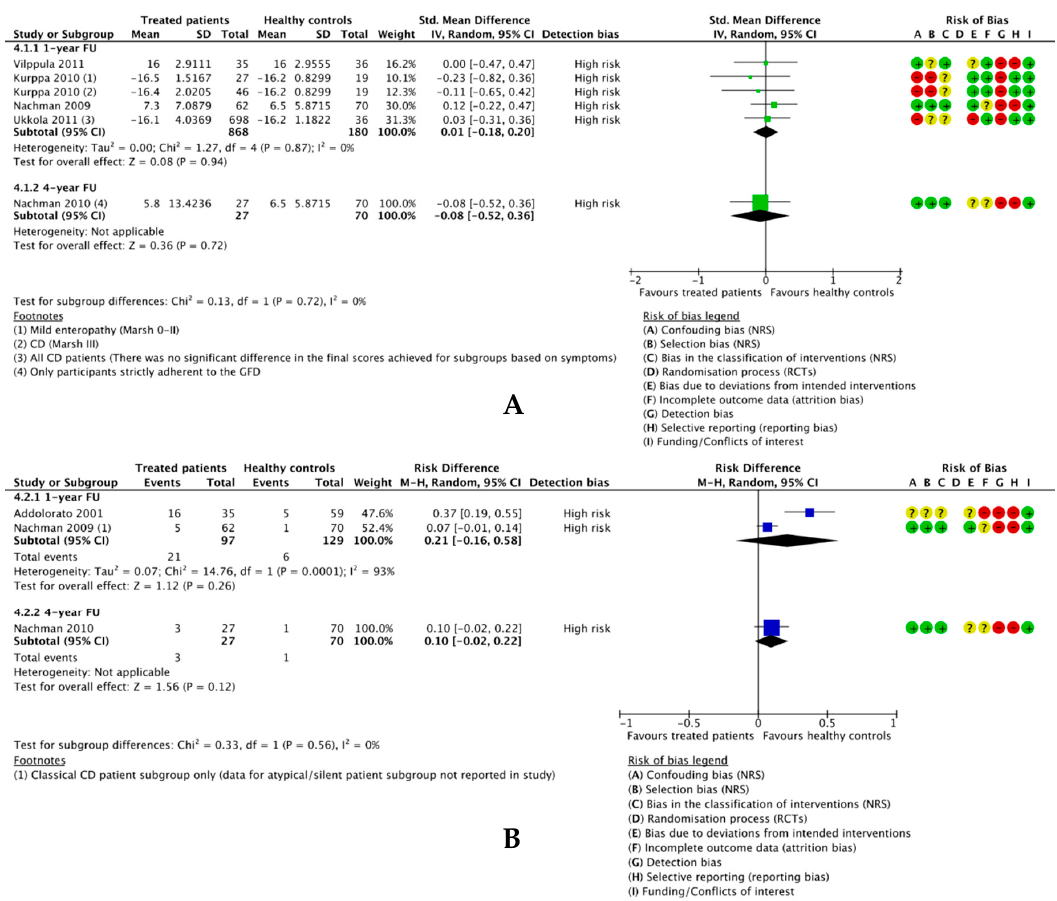
Figure 7. Forest plots comparing: ( A ) Mean depression scores in treated patients and healthy controls and ( B ) the difference in the no. treated patients and healthy controls positive for depression at one year and four years after following a GFD.